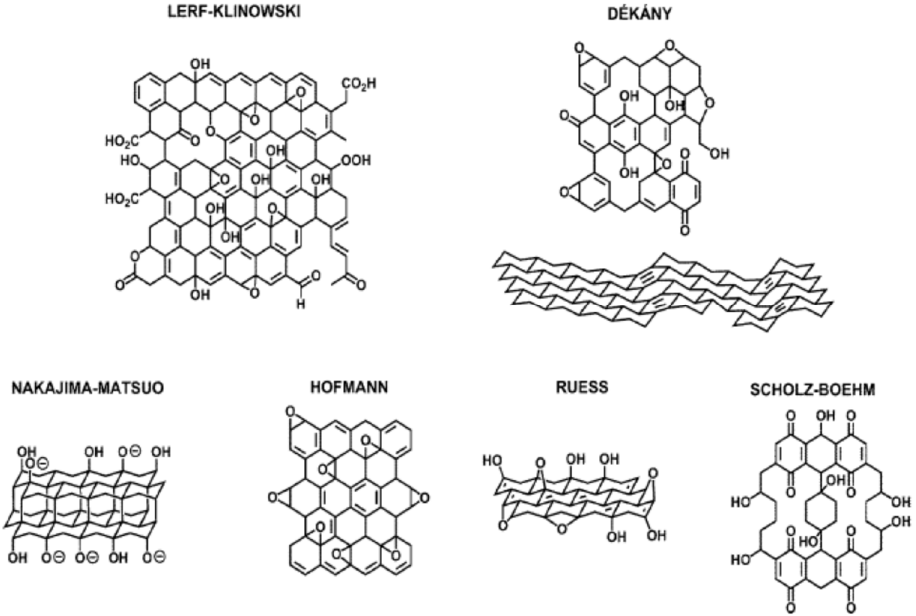
Figure 5. The proposed structural models of GO [60].